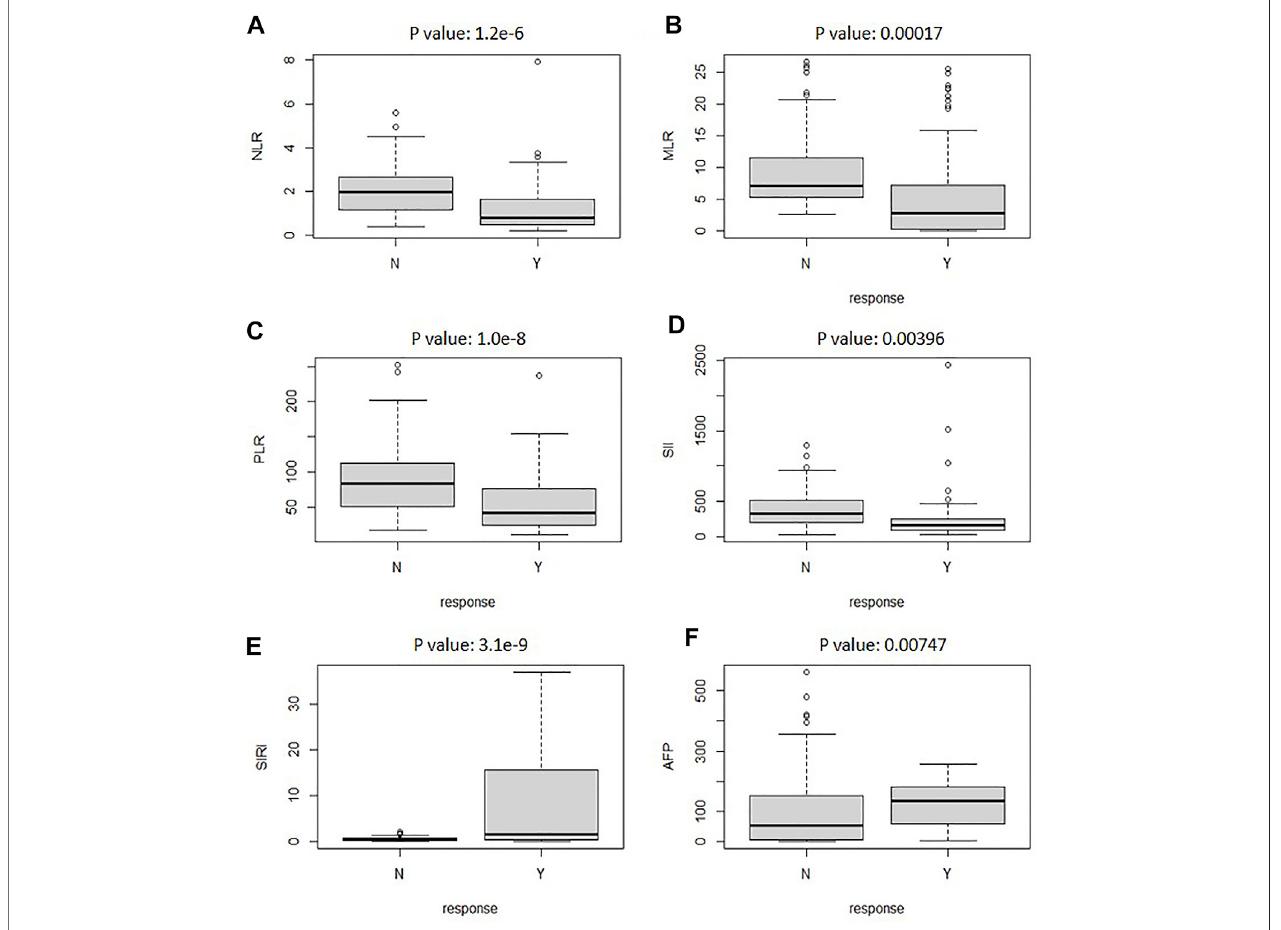
FIGURE5| TheboxplotanalyzedtherelationshipbetweenreactiveandnonreactivevaluesforclinicalevaluationindexesofNLR (A) ,AFP (B) ,SIRI (C) ,SII (D) ,MLR (E) , and PLR (F) .